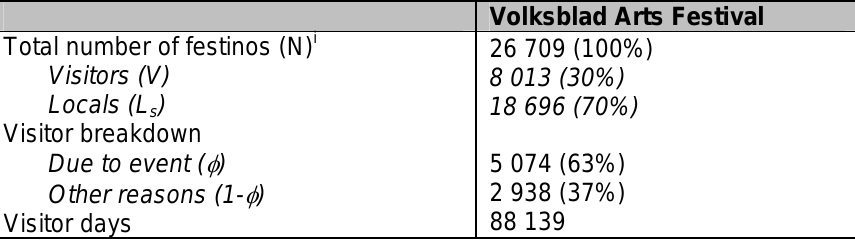
Table 4: Total number of festinos and distribution of festinos